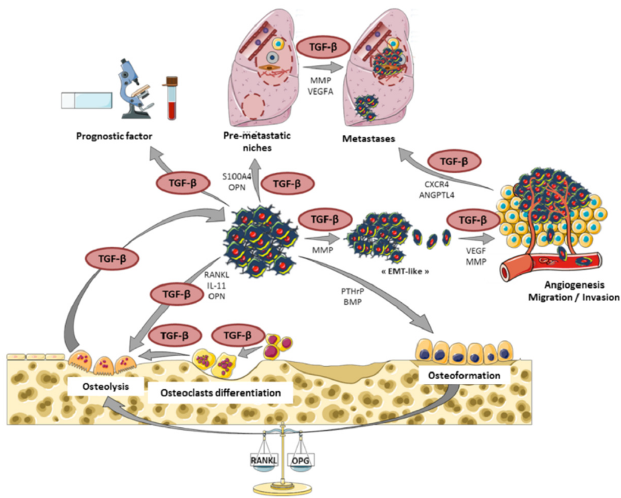
Figure 3. The central role of TGF- β in osteosarcoma tumor and metastases development. Roles of TGF- β as a main player in the vicious cycle between osteosarcoma cells and the bone tumor microenvironment, thus contributing to tumor development and lung metastases dissemination. EMT: epithelial–mesenchymal transition; MMP: matrix metalloproteinase; VEGF: vascular endothelial growth